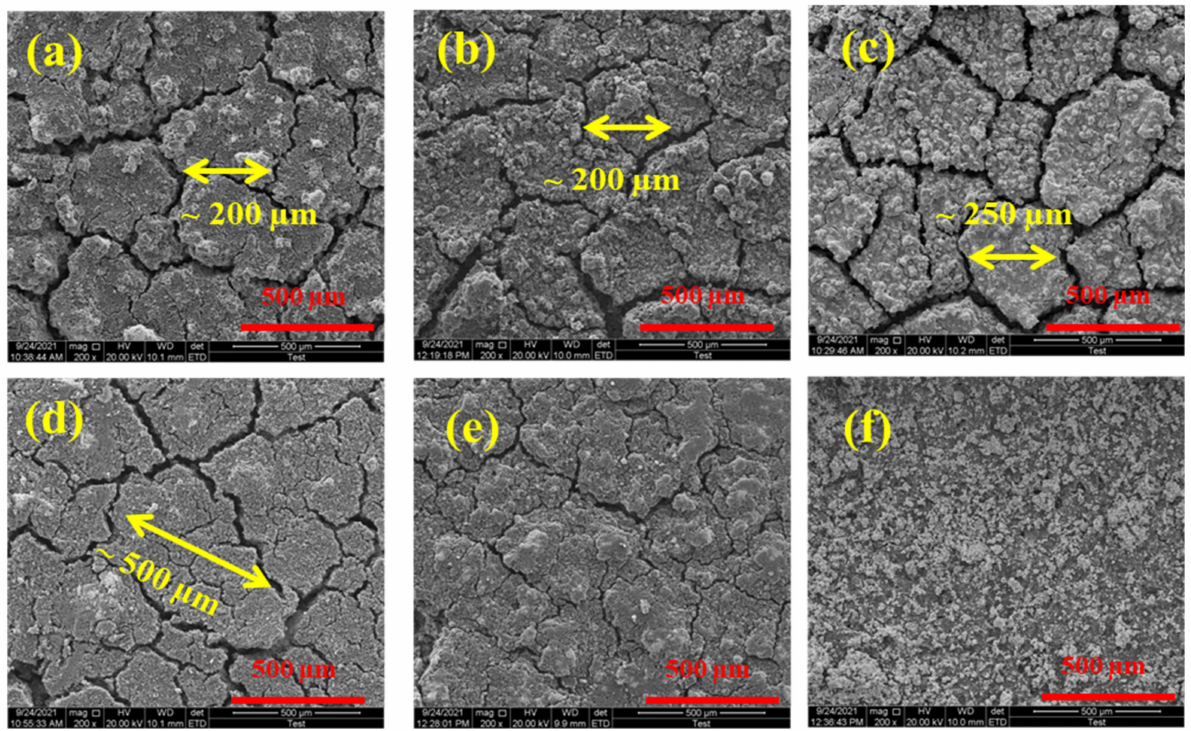
Figure 3. Top-view SEM images of electrodes—standard (( a ) 0 wt.% graphene) and containing graphene (( b ) 2.5 wt.% graphene, ( c ) 5 wt.% graphene, ( d ) 7.5 wt.% graphene, ( e ) 10 wt.% graphene